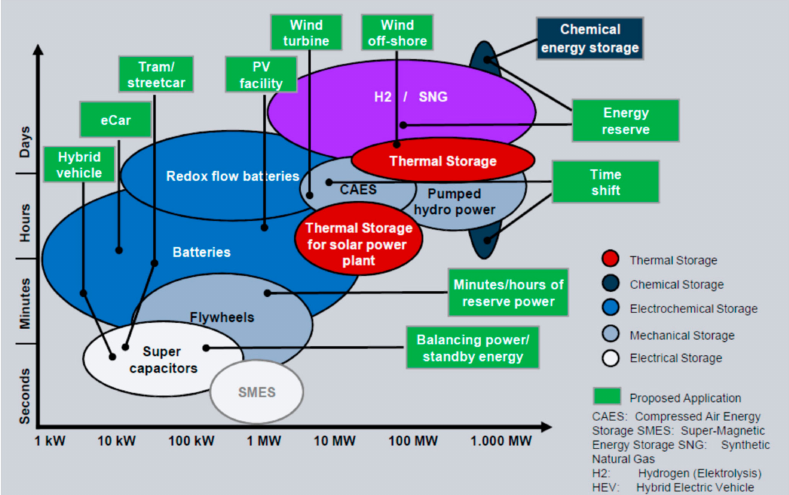
Figure 1. Energy storage technologies concerning typical charge-discharge timescales and available power